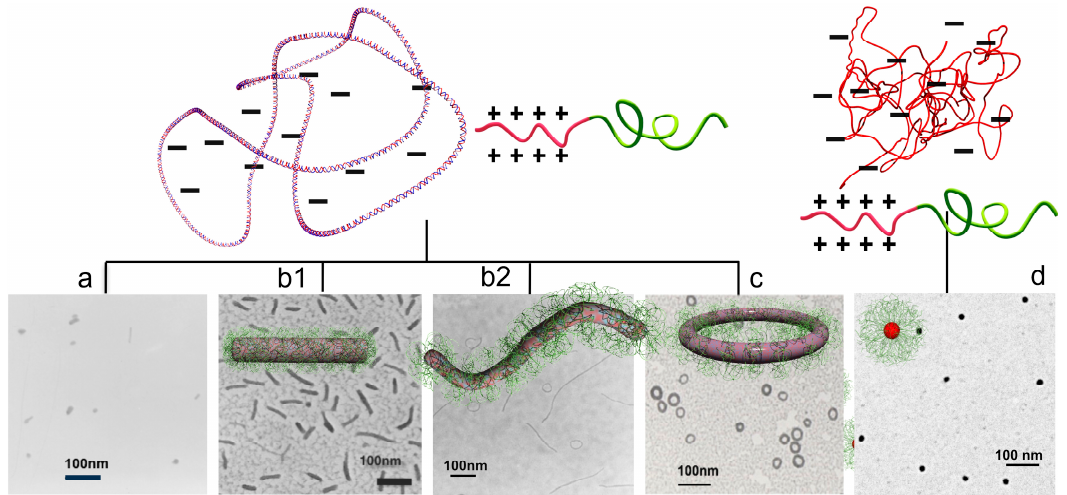
Figure 5. Control of higher-order structures of single pDNA elicited by block copolymers into globular-collapsing ( a ), rod-folding with folded more ( b1 ) or less ( b2 ), and ring-spooling ( c ). Single-strand DNA is folded into spherical ( d